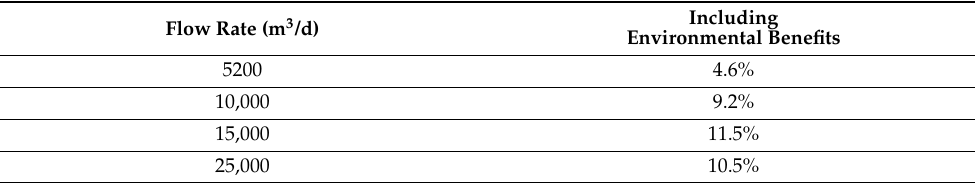
Table 3. Internal rates of return for water reclamation projects for industrial water supply when including environmental benefits .